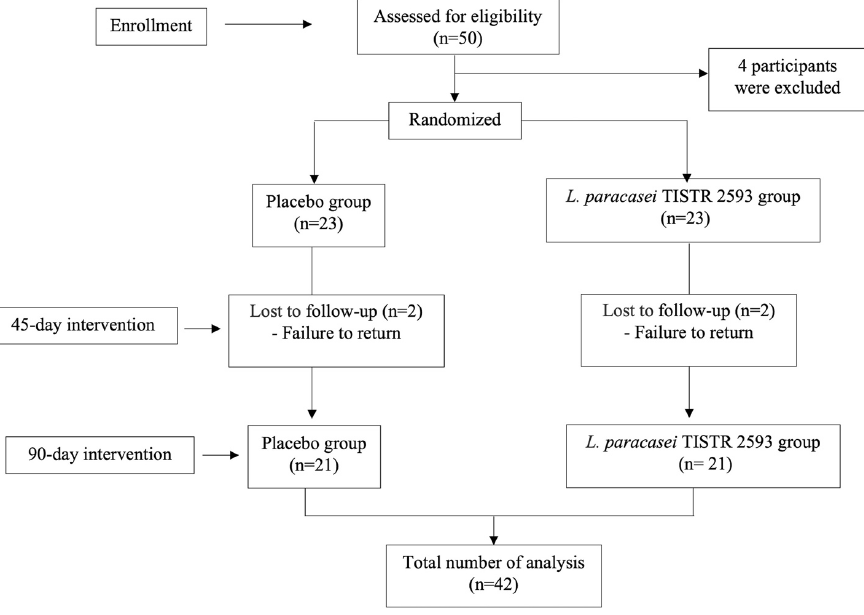
Figure 1. Consort flow diagram.